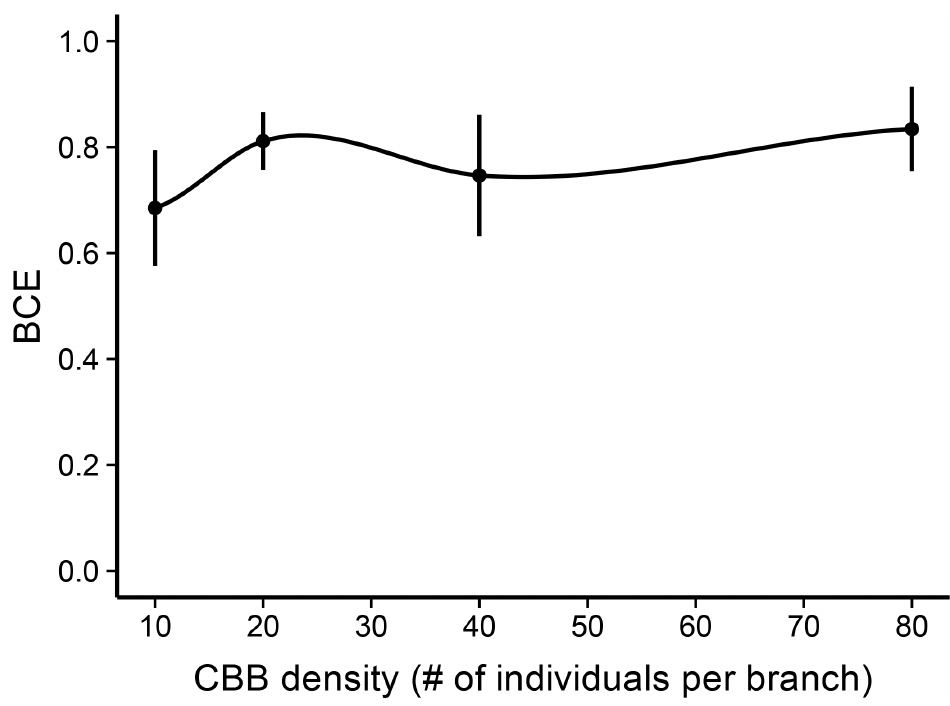
Fig 4. Biocontrol efficiency (BCE) curve. Shows mean BCE ( ± SE) of Azteca sericeasur at each coffee berry borer (CBB) density treatment (10, 20, 40, and 80 individuals). There was no statistical difference in mean BCE across the treatments. The curve illustrates that BCE is maintained at a high level; however, trends between 0 and 10 CBB were not tested. The curve was produced using the “ loess ” smoothing function in the ggplot package in